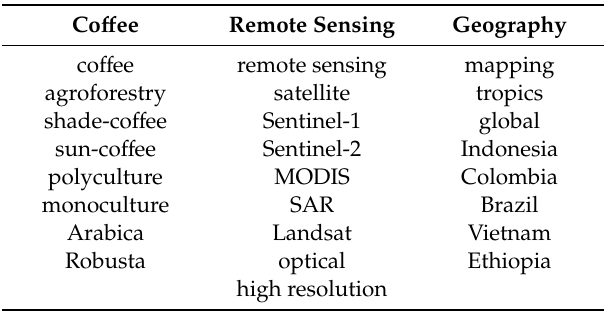
Table 2. Search terms used in Google Scholar to find studies that examine e ff ective remote sensing methods for mapping co ff ee